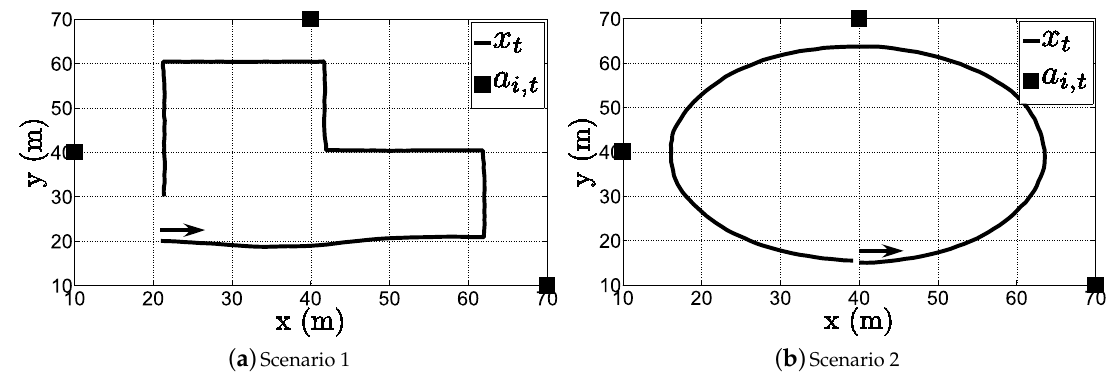
Figure 3. True target trajectory and sensors’ initial locations. The direction of the movement of the target is indicated by the arrow. Table 1. Summary of the simulation parameters. PLE, path loss exponent; PF, particle